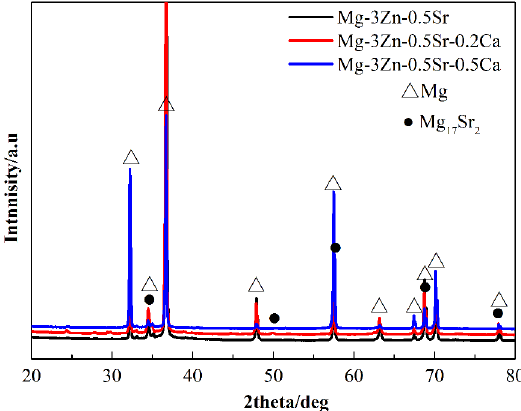
Figure 1. The XRD patterns of Mg-3Zn-0.5Sr-xCa alloys Fig. 3 shows representative potentiodynamic polarization curves of Mg-3Zn-0.5Sr-xCa alloys in SBF solution. The corrosion potential (E ) and corrosion current density (I ) of corr corr alloys were -1.656V, -1.609V, -1.646V and 1.35×10 -4 A·cm -2 ,